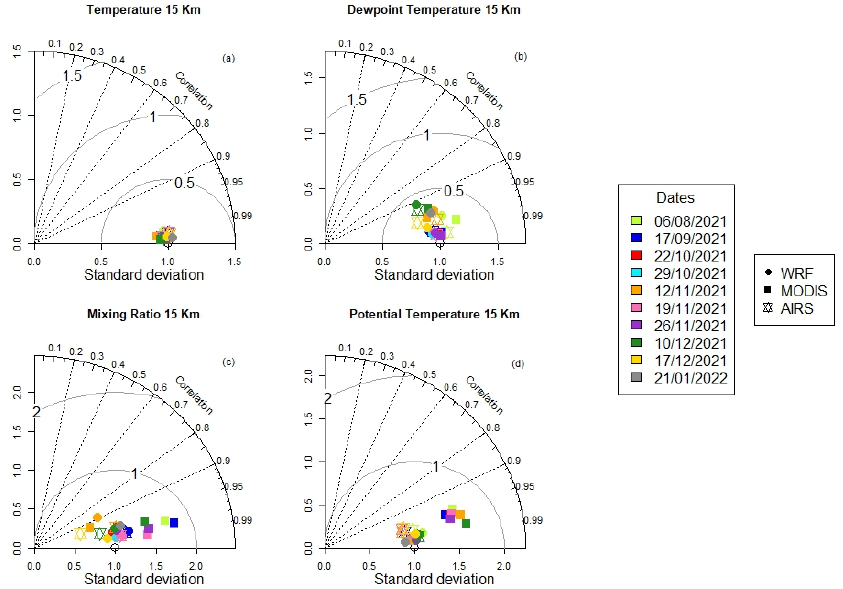
Figure 8. Normalized Taylor Plots for 10 measurement events up to 15,000 magl. of different atmospheric variables: ( a ) Temperature, ( b ) Dewpoint temperature, ( c ) Mixing ratio, and ( d ) Potential temperature.